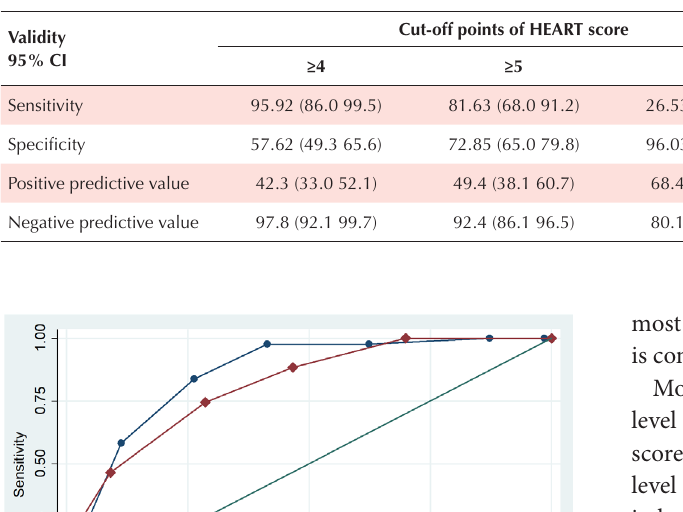
Table 3. Validity of HEART vs TIMI score in MACE prediction